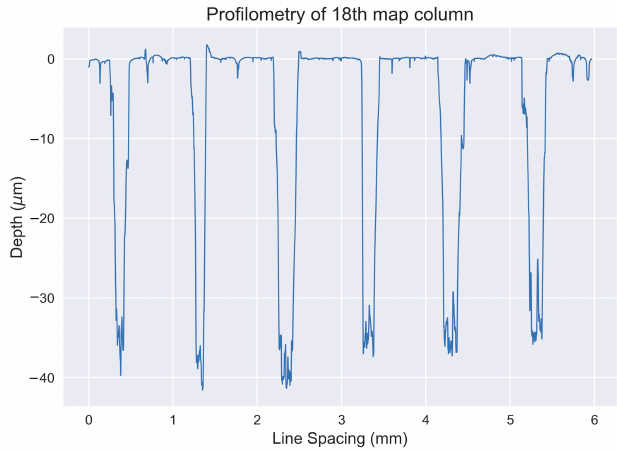
Figure 11. Profilometry along the first six craters of the 18th map column.